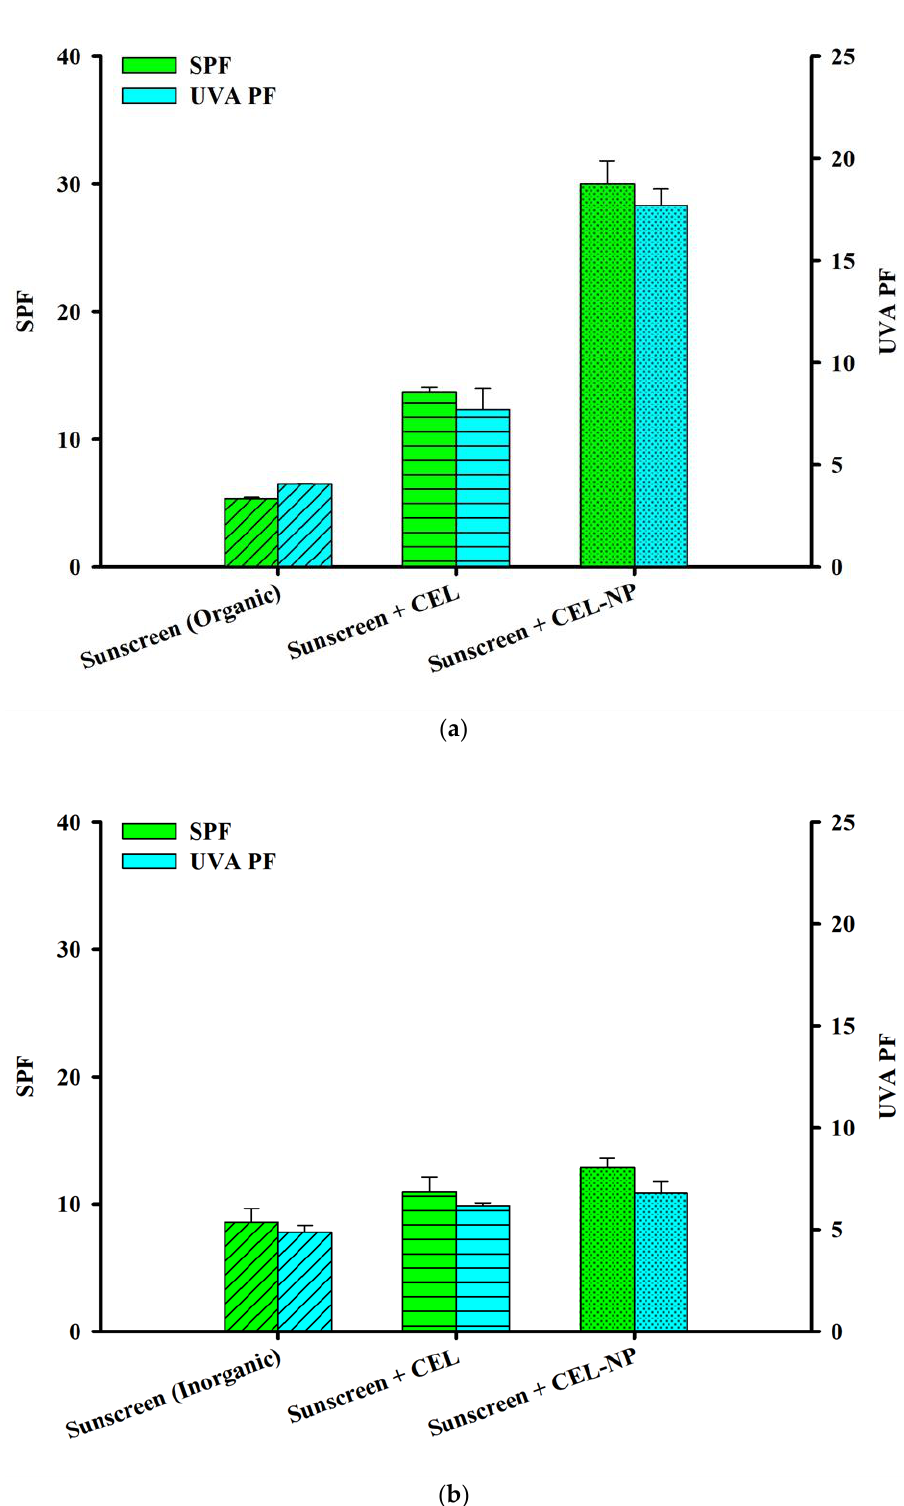
Figure 6. SPF and UVA PF values of lignin-blended sunscreens (5 wt %) based on ( a ) organic UV filters and ( b ) inorganic UV filters. and ( b ) inorganic UV